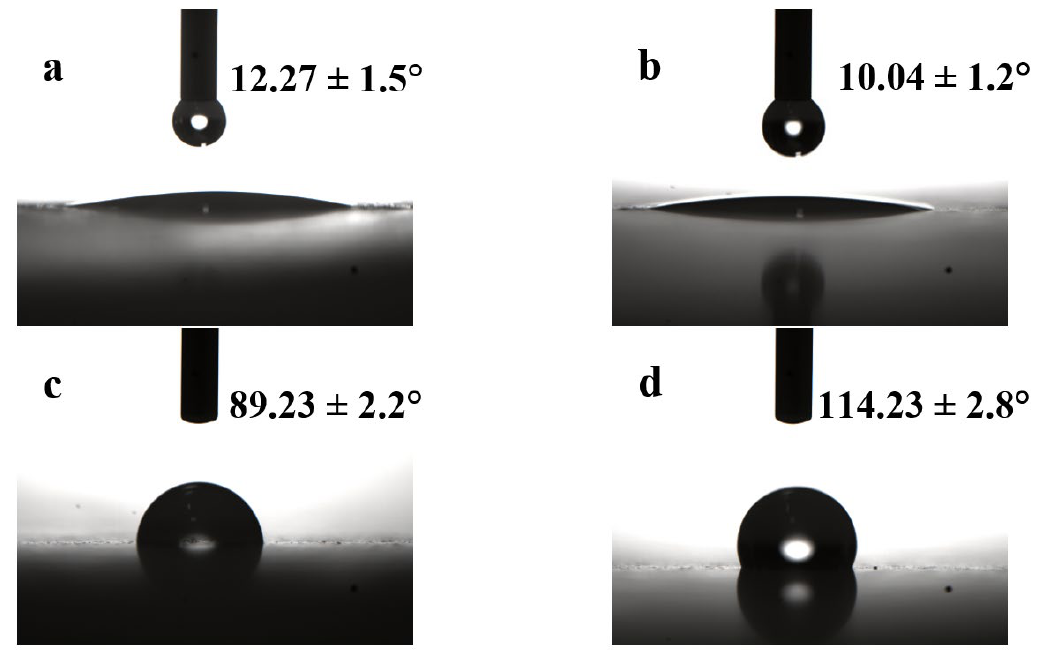
Figure 6. The water contact angles on the surfaces of the ( a ) untreated CSWs, ( b ) CSW-OH, ( c ) CSW-OH-KH570, and ( d ) CSW-g-PMMA.